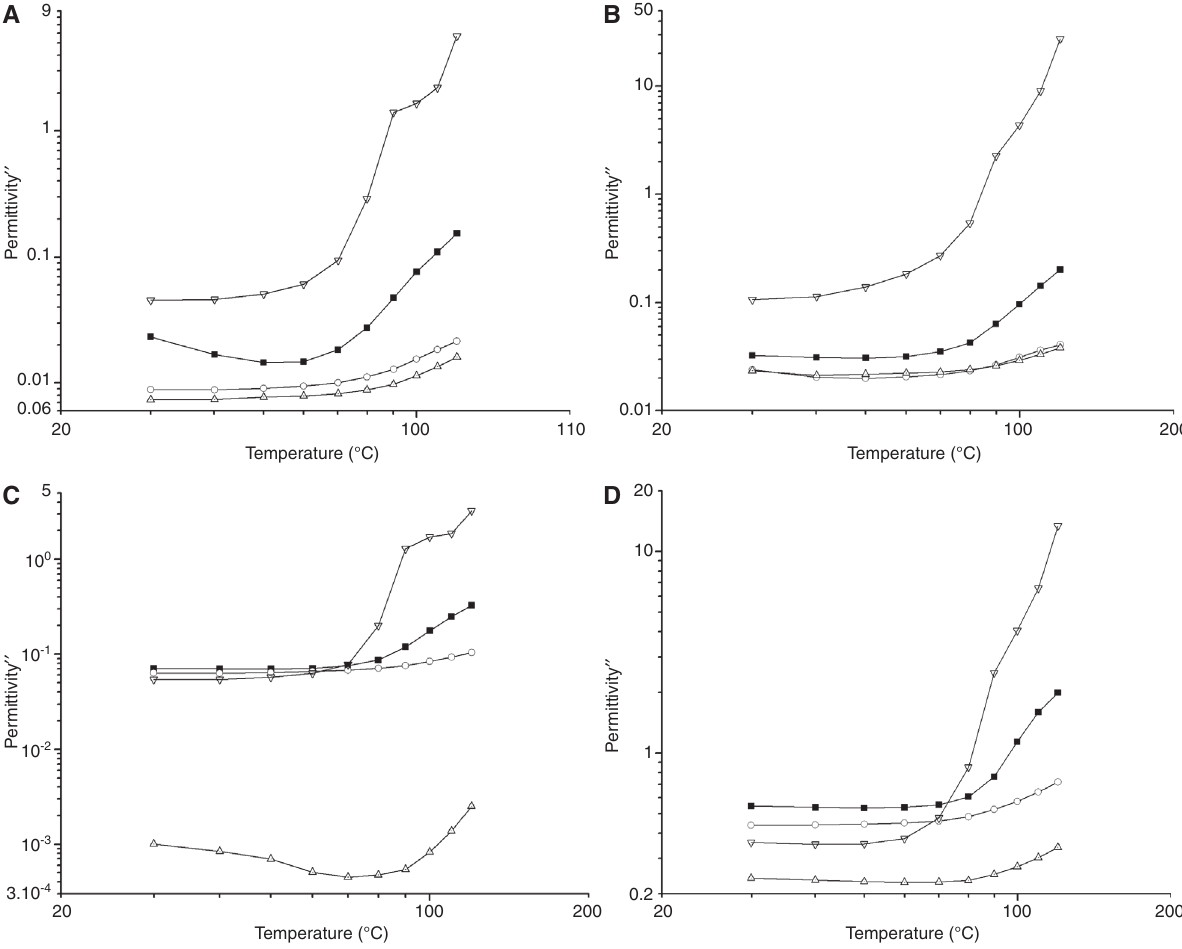
Figure 8 Dielectric losses ( ε ″ ) at 50 Hz related to the temperature. (A) Compound+5% GTR, (B) compound+10% GTR, (C) compound+20% GTR, and (D) compound+50% GTR: ■, EVA; ○, HDPE; ∆, PP; ,